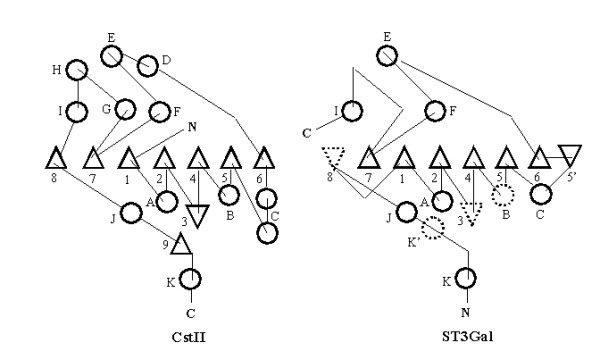
Topology diagrams for CstII (PDB ID: 1RO7) and modeled ST3Gals. Triangles and circles represent strands and helices, respectively. Strands 5' and 8 are antiparallel to other strands in ST3Gals and are hence inverted. Certain helices and strands are not found in all the modeled ST3Gals (Figure 1) and these are represented by dotted lines. The nomenclature used to identify strands and helices in CstII are the same as those used by Chiu et al. [13]. The equivalent secondary structure elements in ST3Gals are identified by the same names. Strand 9 and helices D, G and H are absent in ST3Gals; strand 5' and helix K' are absent in CstII. Note that the region of the polypeptide from strand 8 till helix K is at the C-terminus in CstII but they are at the N-terminus in ST3Gals; hence, the direction of the polypeptide chain is opposite to one another in this region.